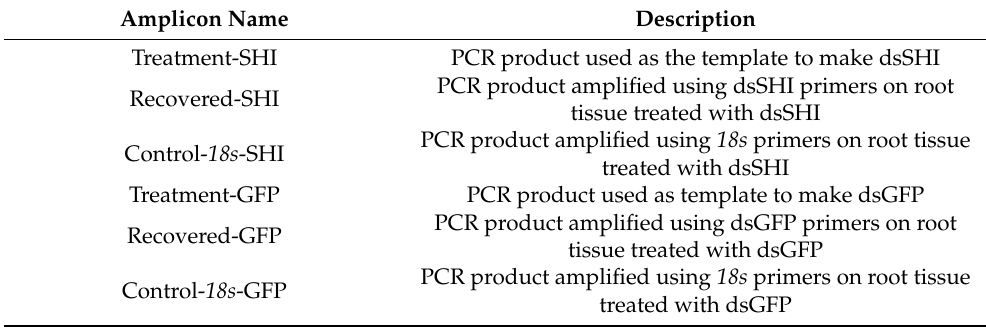
Table 2. The unique genetic products from loblolly pine seedlings treated with dsRNAs that were Sanger sequenced. Amplicon names are categorical references to different types of genetic